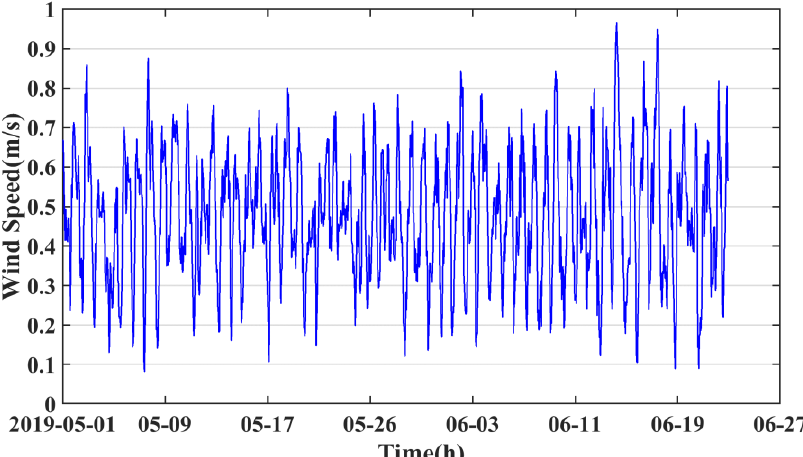
Figure 7. Normalization results of meridional wind at 86 km from 1 May to 23 June 2019.